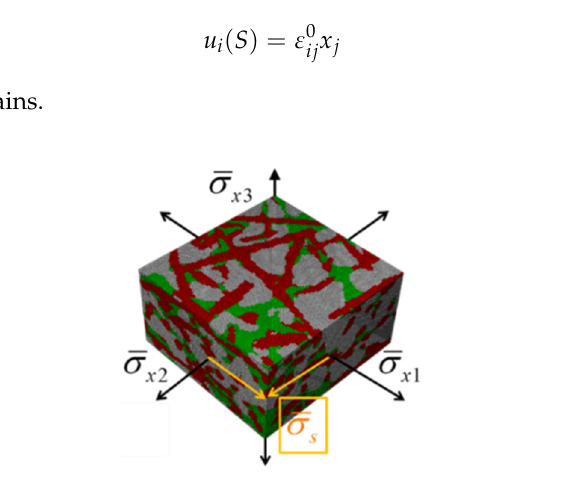
Figure 4. Boundary conditions for calculating components.